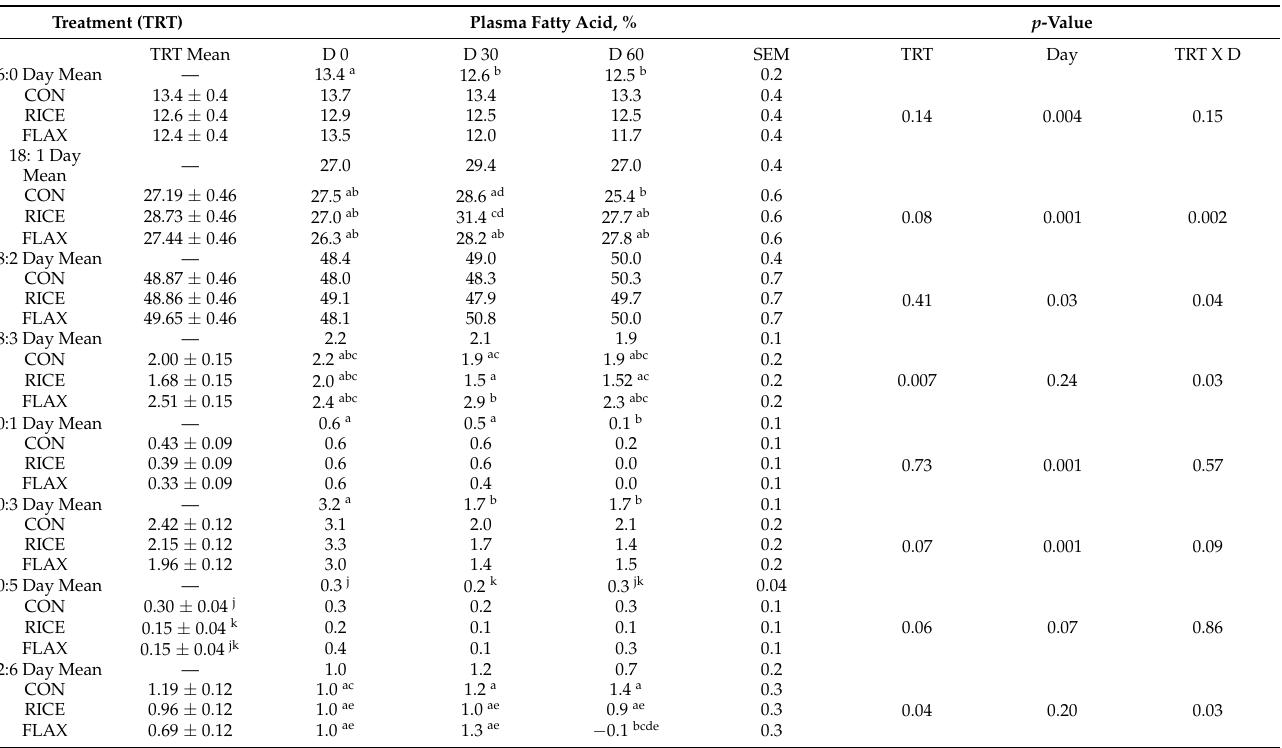
Table 3. Mean ± SEM fatty acid profile of plasma lipids 1 in long yearlings consuming hay and a pelleted concentrate with no oil (CON) or either crude rice bran oil (RICE) or a flaxseed oil blend (FLAX) replacing 25% of concentrate calories daily for 60